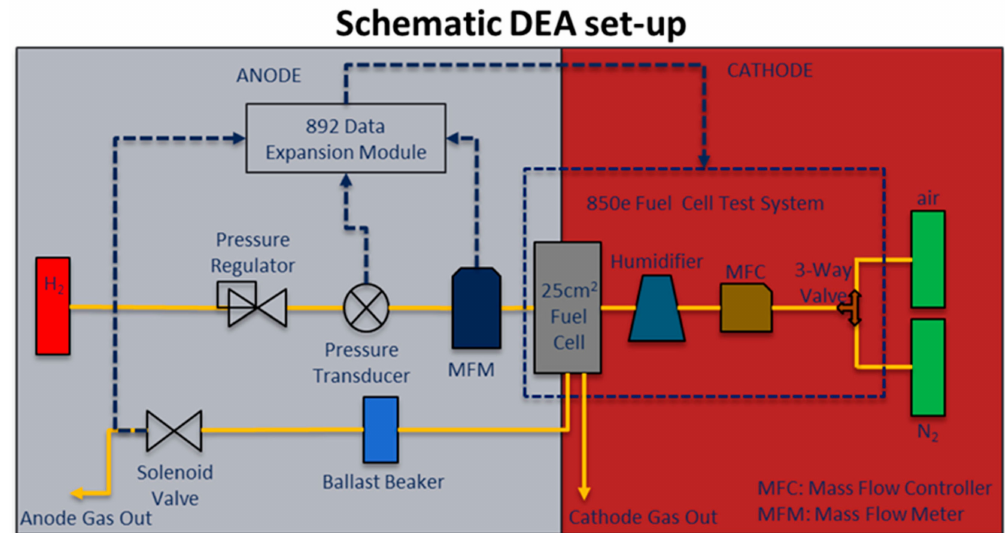
Figure 1. Experimental set-up schematic to test a single cell PEMFC in dead-ended anode (DEA)